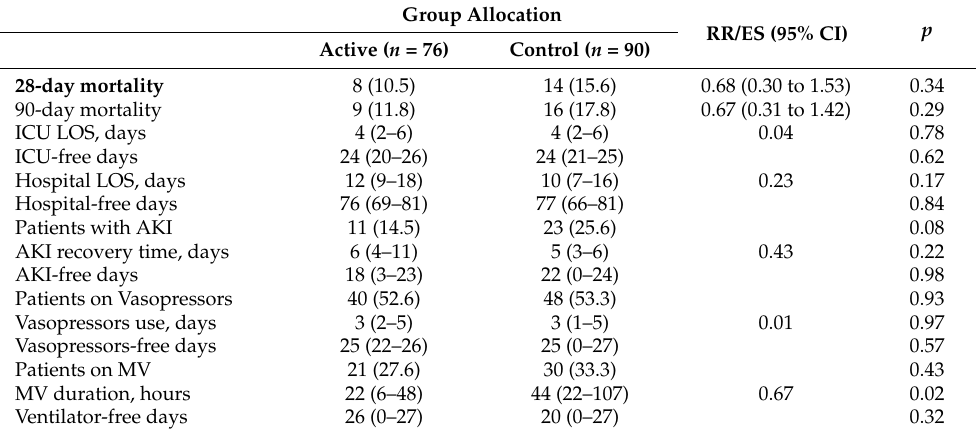
Table 5. Primary and secondary